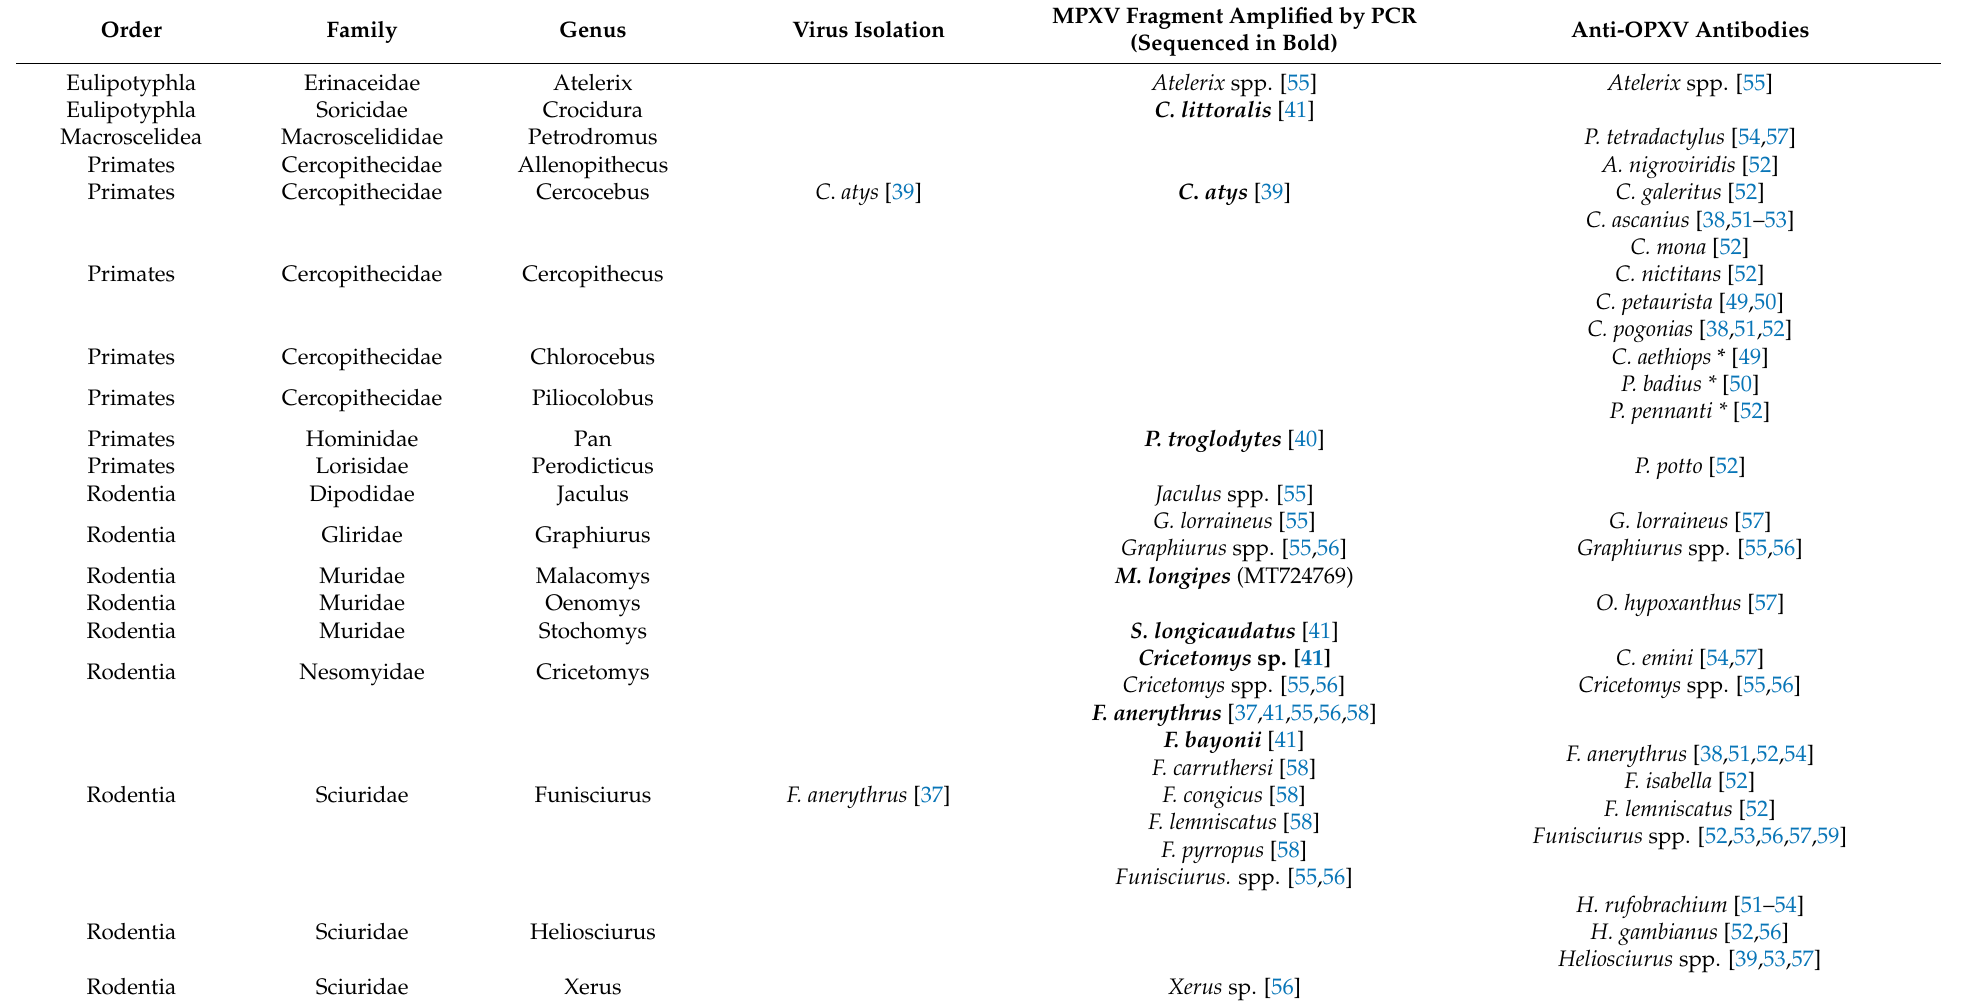
Table 1. Mammal genera and species potentially involved as reservoir or secondary hosts of